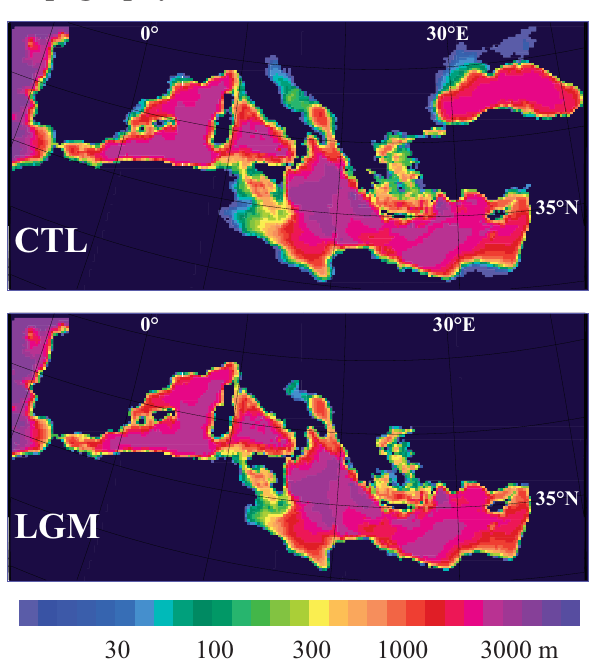
Fig. 1. Model topography in m for CTL (top) and LGM (bottom). Geographical coordinates are drawn for every 10 ◦ in longitude and 5 ◦ in